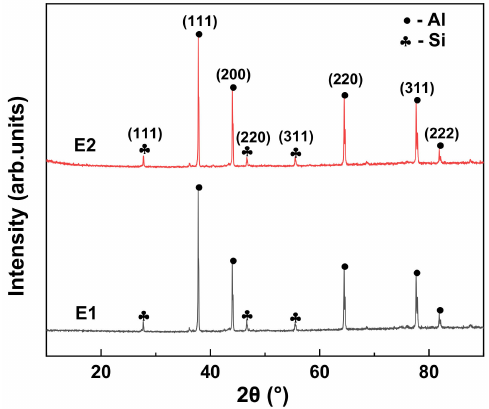
Figure 1. XRD results of the as-deposited